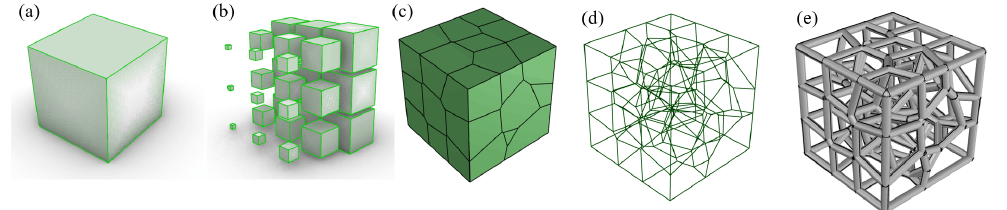
Figure 1. Design process of gradient Voronoi structure: ( a ) Select the cube as the design space. ( b ) Divide the square into nine small squares with equal differences. ( c ) Randomly generate a seed point inside each small cube and Voronoi polyhedrons with common edges. ( d ) Frame lines of gradient Voronoi structure. ( e ) Gradient Voronoi.